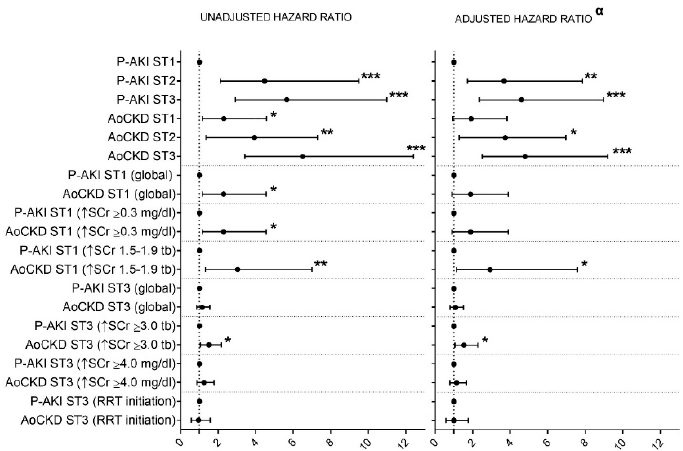
Figure 3. Unadjusted and adjusted hazard ratios (95% confidence interval) for death. P-AKI: Pure acute kidney injury. AoCKD: Acute-on-chronic kidney disease. AKI: Acute kidney injury. ST1: AKI stage 1. ST2: AKI stage 2. ST3: AKI stage 3. SCr: Serum creatinine. Tb: Times baseline. RRT: Renal